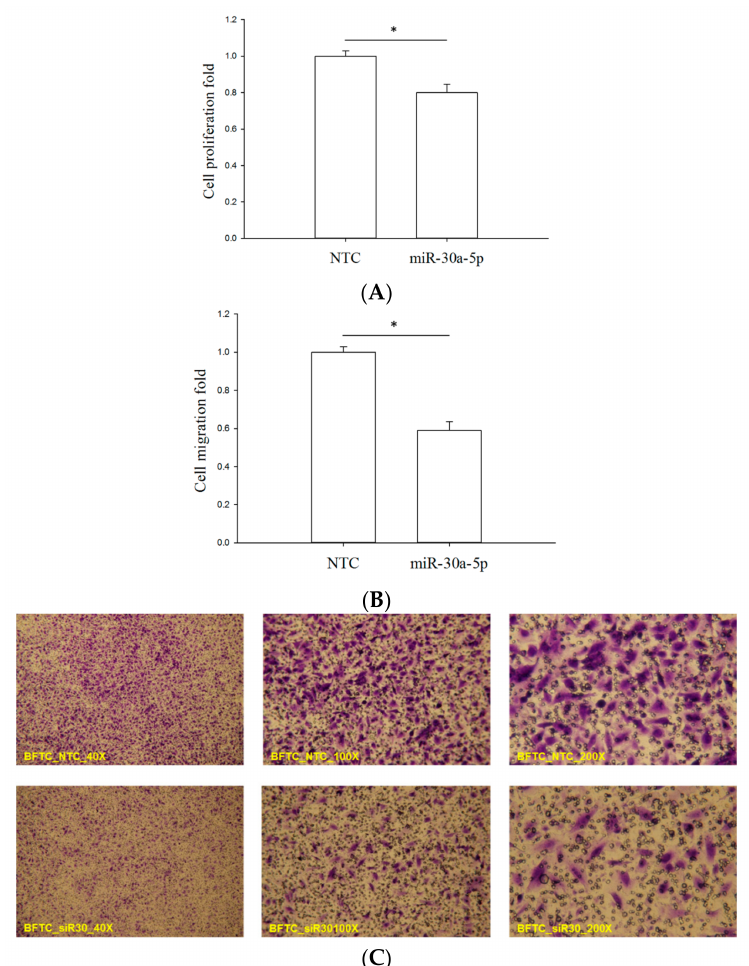
Figure 4. The suppressive effect of miR-30a-5p on the proliferation and migration of UTUC cells. BFTC-909 cells were transfected with miR-30a-5p mimetic agent, followed by WST-1 and trans-well assays. NTC denotes non-transfection controls with scrambled mimetic treatment. ( A ) After mimetic transfection for 48 h, the WST-1 assay was used to evaluate cell numbers. The WST-1 value is directly proportional to cell number; ( B ) After mimetic transfection for 72 h, trans-well migration assay was performed to evaluate the cell migration ability; ( C ) The crystal violet-stained cells are those penetrating the trans-well membrane. All data are shown as means ± SEM from three independent experiments. * indicates that p < 0.001 between the indicated